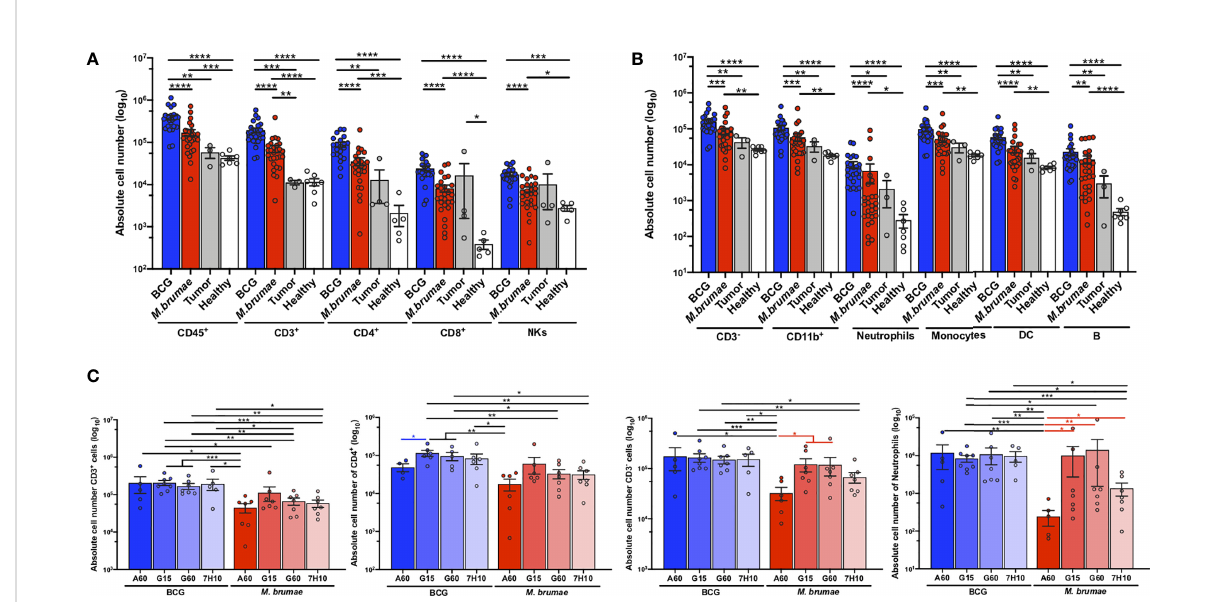
FIGURE 1 Robust in fi ltration of immune cells into the bladder after mycobacteria treatment. Absolute counts of (A) total live CD45 + cells, CD3 + , CD4 + and CD8 + T-cells, and NK + cells (CD3 - NK1.1 + ); and (B) CD3 - cells, CD11b + myeloid cells (CD3 - B220 - CD11b + ), neutrophils (CD3 - B220 - Ly6C + Ly6G + ), monocytes (CD3 - B220 - Ly6G - CD11b + ), dendritic cells (CD3 - B220 - Ly6G - CD11c + ) and B-cells (CD3 - B220 + ) were quanti fi ed by fl ow cytometry after bladder digestion of healthy mice (white bars and dots), untreated tumor-bearing mice (grey bars and dots) and mycobacteria-treated mice, either BCG (blue bars and dots) or M. brumae (red bars and dots) regardless the medium used to growth mycobacteria. (C) Absolute in fi ltration of total CD3 + T-cells, CD4 + T-cells, total CD3 - cells and neutrophils of mice which received BCG (blue bars) or M. brumae (red bars) grown in different culture media. Each dot represents an individual mouse. Data represent the mean (bars) and ± SEM (error bars) and each dot represent an individual mouse. Statistically signi fi cant differences between the different BCG and M. brumae mycobacteria (intrastrain) are shown as blue and red lines, respectively. Interstrain differences or with the untreated groups (healthy and tumor) are shown in black. Differences were tested using Mann-Whitney U nonparametric test. *p ≤ 0.05; **p ≤ 0.01; ***p ≤ 0.001; ****p ≤